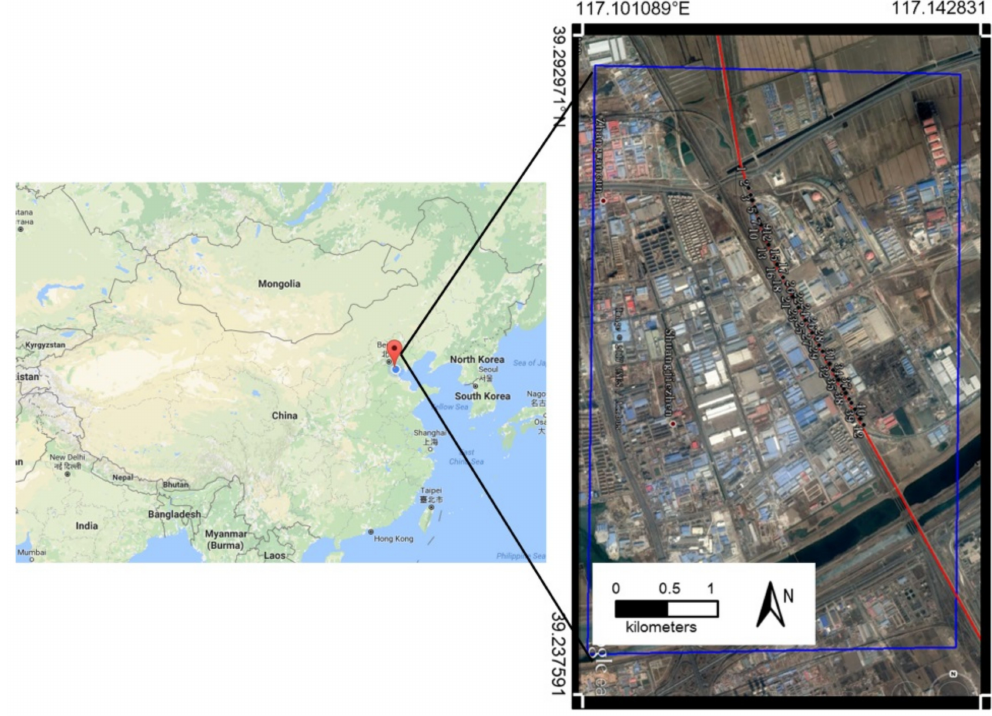
Figure 1. The study area and TSX data. The location of the study area, in China, is highlighted with a red dot which is zoomed in and illustrated in the right inset, as shown by the blue frame. The locations of leveling points along Jingjin Inter-City railway were marked with black